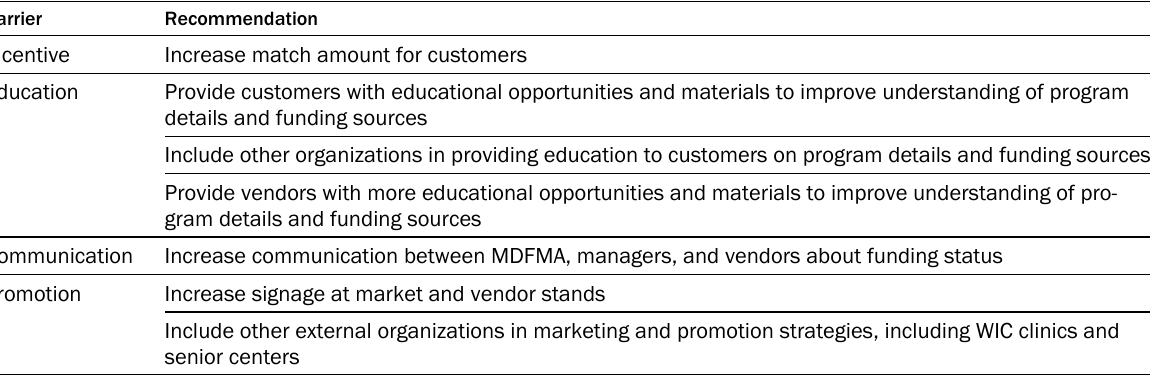
Table 2. Vendor Recommendations to Improve Maryland Market Money ( n =19)